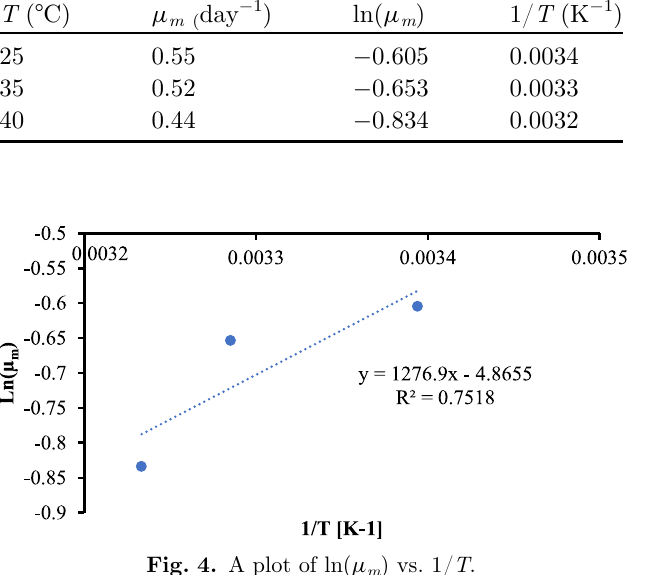
Table 3. Half saturation coef fi cient at different